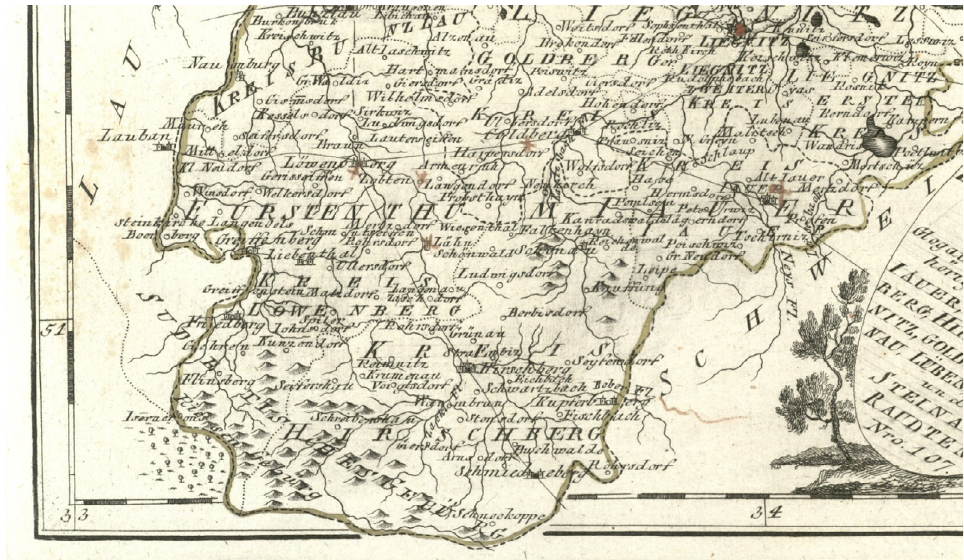
Fig. 5. Southern part of the Duchy of Jawor on the map from F.J.J. Reilly’s atlas of